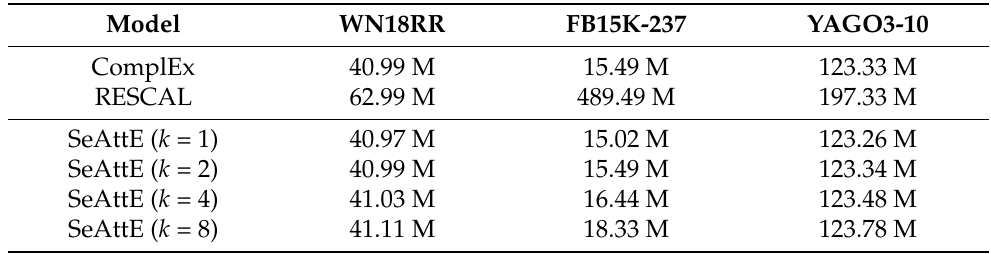
Table 6. This is the comparison of parameters between ComplEx, RESCAL and SeAttE, when entities have the same dimension ( d = 1000).